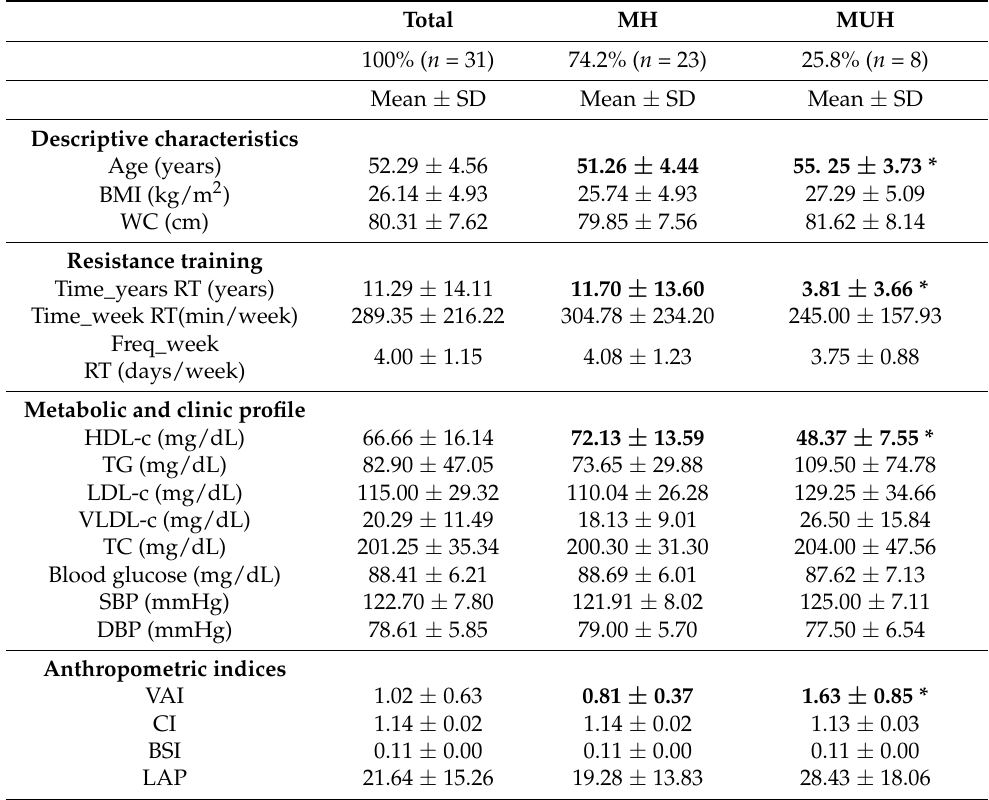
Table 1. Characteristics of the total sample and according to MH and MUH phenotypes.